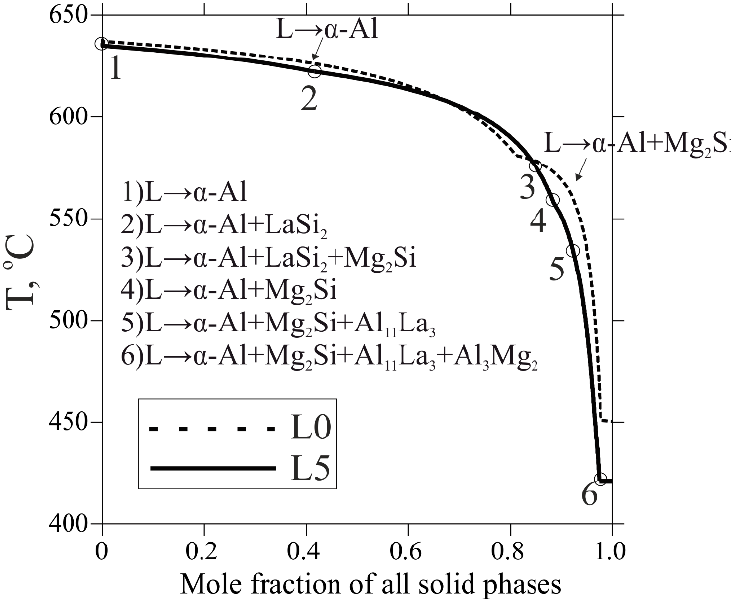
Figure 3. Calculated non-equilibrium solidification curves of the L0 and L5 alloys according to Scheil–Gulliver simulation. Table 2. Calculated critical solidification temperatures of the experimental alloys.